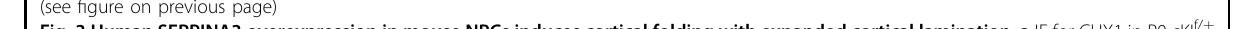
All information is shown in t-SNE plots (Fig. 4b, c). The ratio of different cell types was also calculated (Fig. 4d).